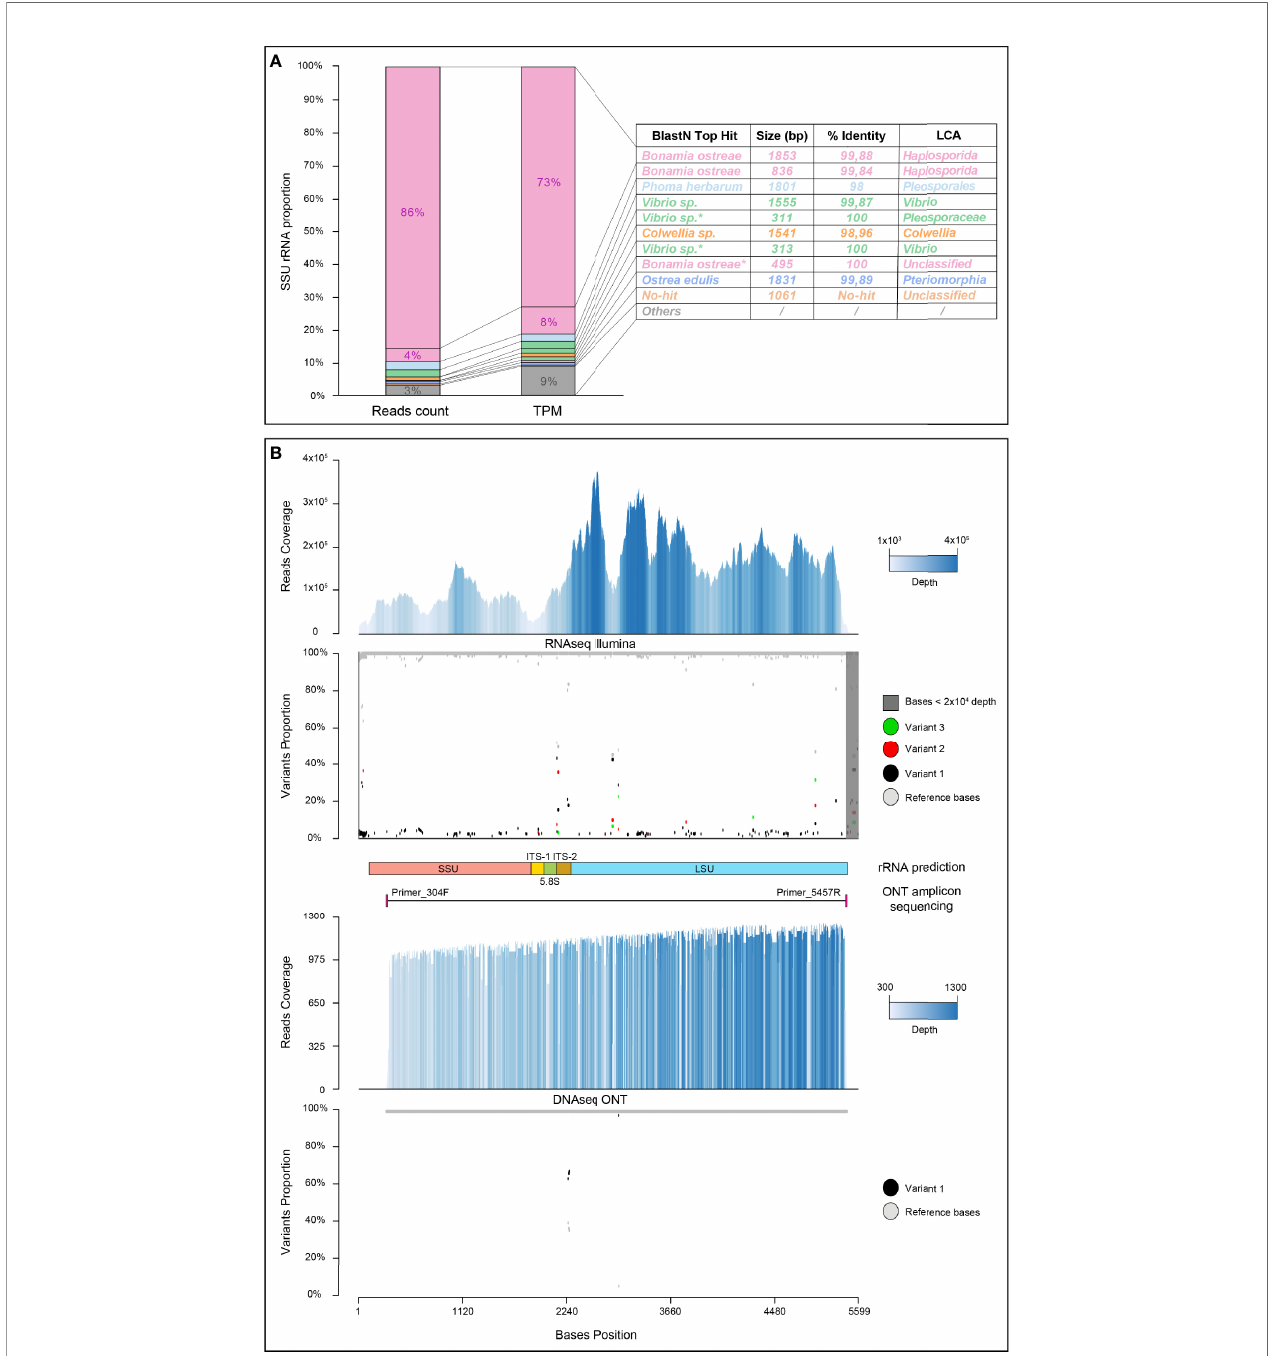
FIGURE 3 | Description of the rRNA transcript population. (A) Taxonomic classi fi cation of the top ten expressed rRNA transcripts identi fi ed using SILVA ATC and BlastN with their respective read counts and expression values. LCA, last common ancestor; TPM, transcripts per million. *Multiple top hits with the same percentage of identity and e-value. (B) Characterization of the putative B. ostreae rRNA operon. The fi rst panel represents Illumina read coverage on the putative rRNA operon color coded from light blue 1 × 10 3 read depth to dark blue 4 × 10 5 read depth. The second panel shows the diversity analysis performed by Freebayes from the Illumina read alignment on the putative operon. The top three variants are color coded in red, blue, and green relative to the reference base in grey. Regions with low read coverage (<2 × 10 4 ) were masked (dark grey) and did not have variants called. The third panel highlights the structures of ribosomal subunits predicted by Infernal and the positions of PCR primers used for nanopore amplicon sequencing. The fourth panel represents ONT read coverage on the putative rRNA operon, color coded from light blue 300 read depth to dark blue 1,300 read depth. The fi fth panel shows the diversity analysis performed by PEPPER from the ONT read alignment on the putative operon. Variants are color coded in red relative to the reference base in